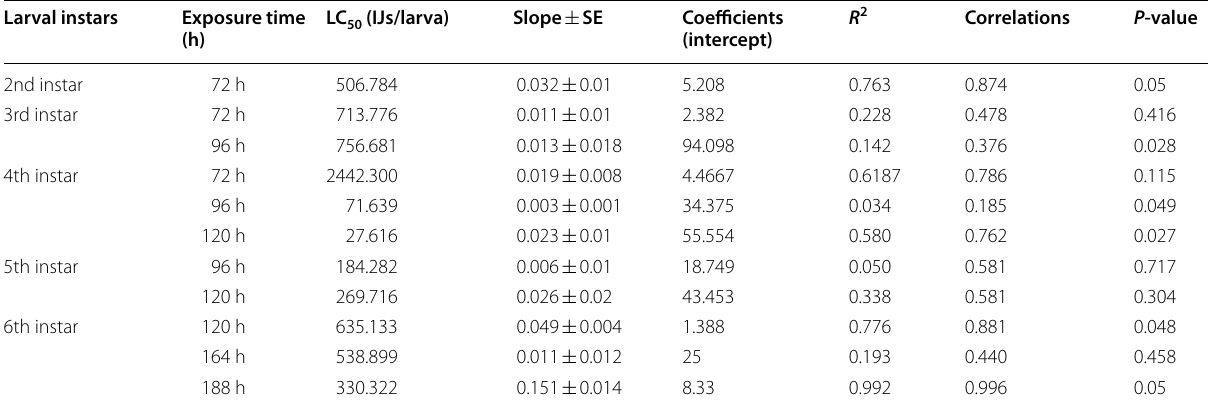
Table 2 Pathogenicity of Heterorhabditis indica nematode against different larval instars of Spodoptera frugiperda at different concentrations (IJs/ml) and exposure